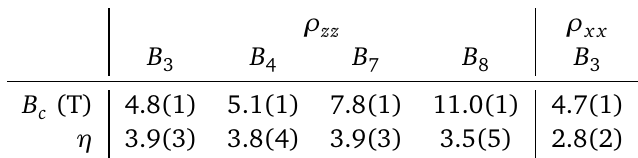
and ρ . Errors denote standard errors from the least-squares zz xx